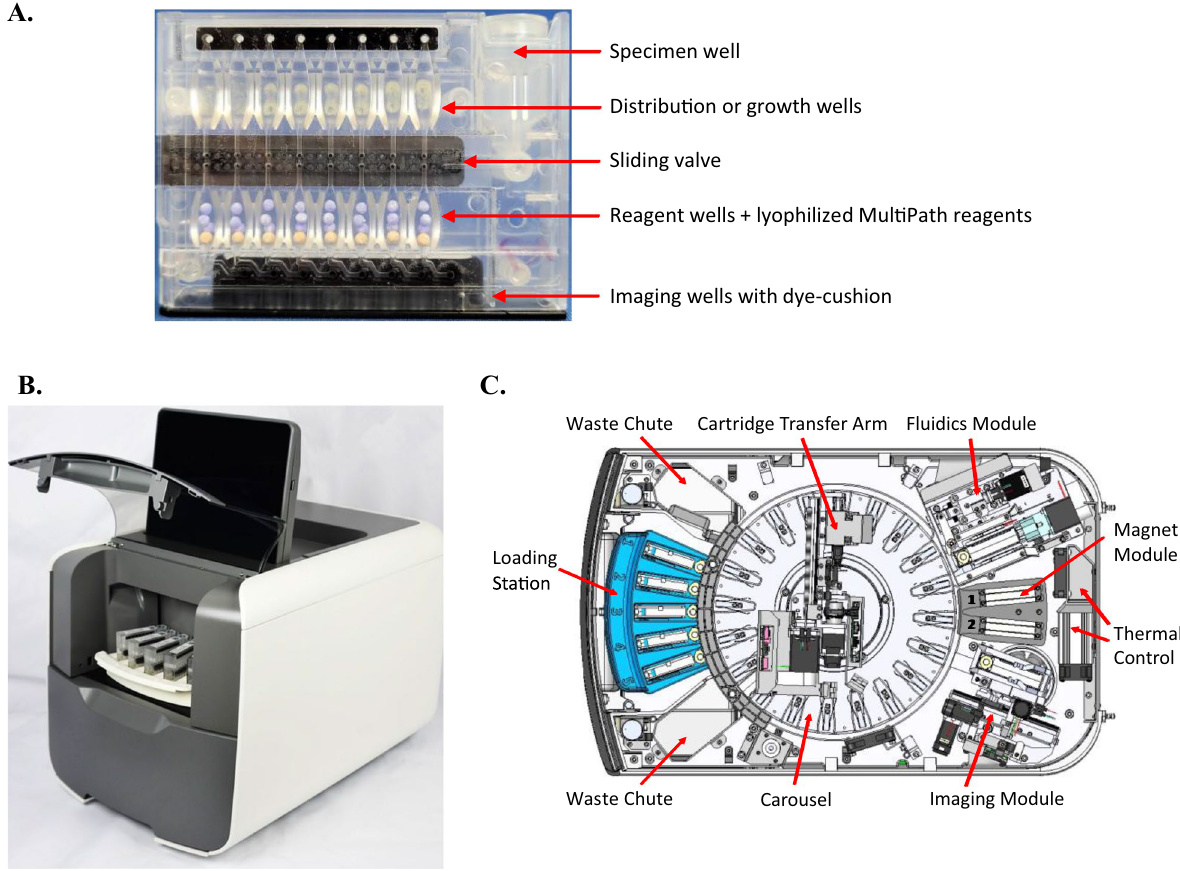
Figure 1. MultiPath cartridge and analyzer. ( A ) Picture of a MultiPath UTI cartridge showing the key features. ( B ) Exterior view of the MultiPath benchtop analyzer showing the cartridge loading bay and user interface touchscreen. Dimensions are 15 ″ W × 25 ″ D × 23 ″ H. ( C ) Top view schematic of the interior of the MultiPath analyzer showing the major